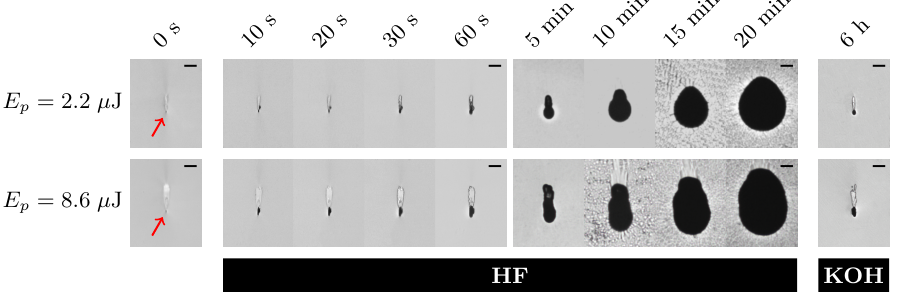
Figure 6. Microscope pictures of the cross-section of the irradiated tracks prior to etching (leftmost images), and after a different time of immersion in etching baths of HF or KOH. Red arrows point to the dark dots in the cross-section of the track, which corresponds to the point of maximum etching sensitivity. The two rows of images regard tracks written with two different values of E p , v t = 1 mm/s and 25 kHz repetition rate. The length of the scalebars is 5 µ